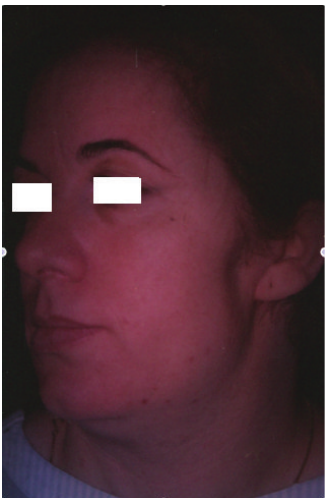
Figure 1: 56 year-old patient, one year after a left parotidectomy without any primitive reconstructive procedure, presenting an obvious concave preauricular deformity. A secondary lipofilling was performed, leading to a permanent facial paresis and a poor cosmetic result.